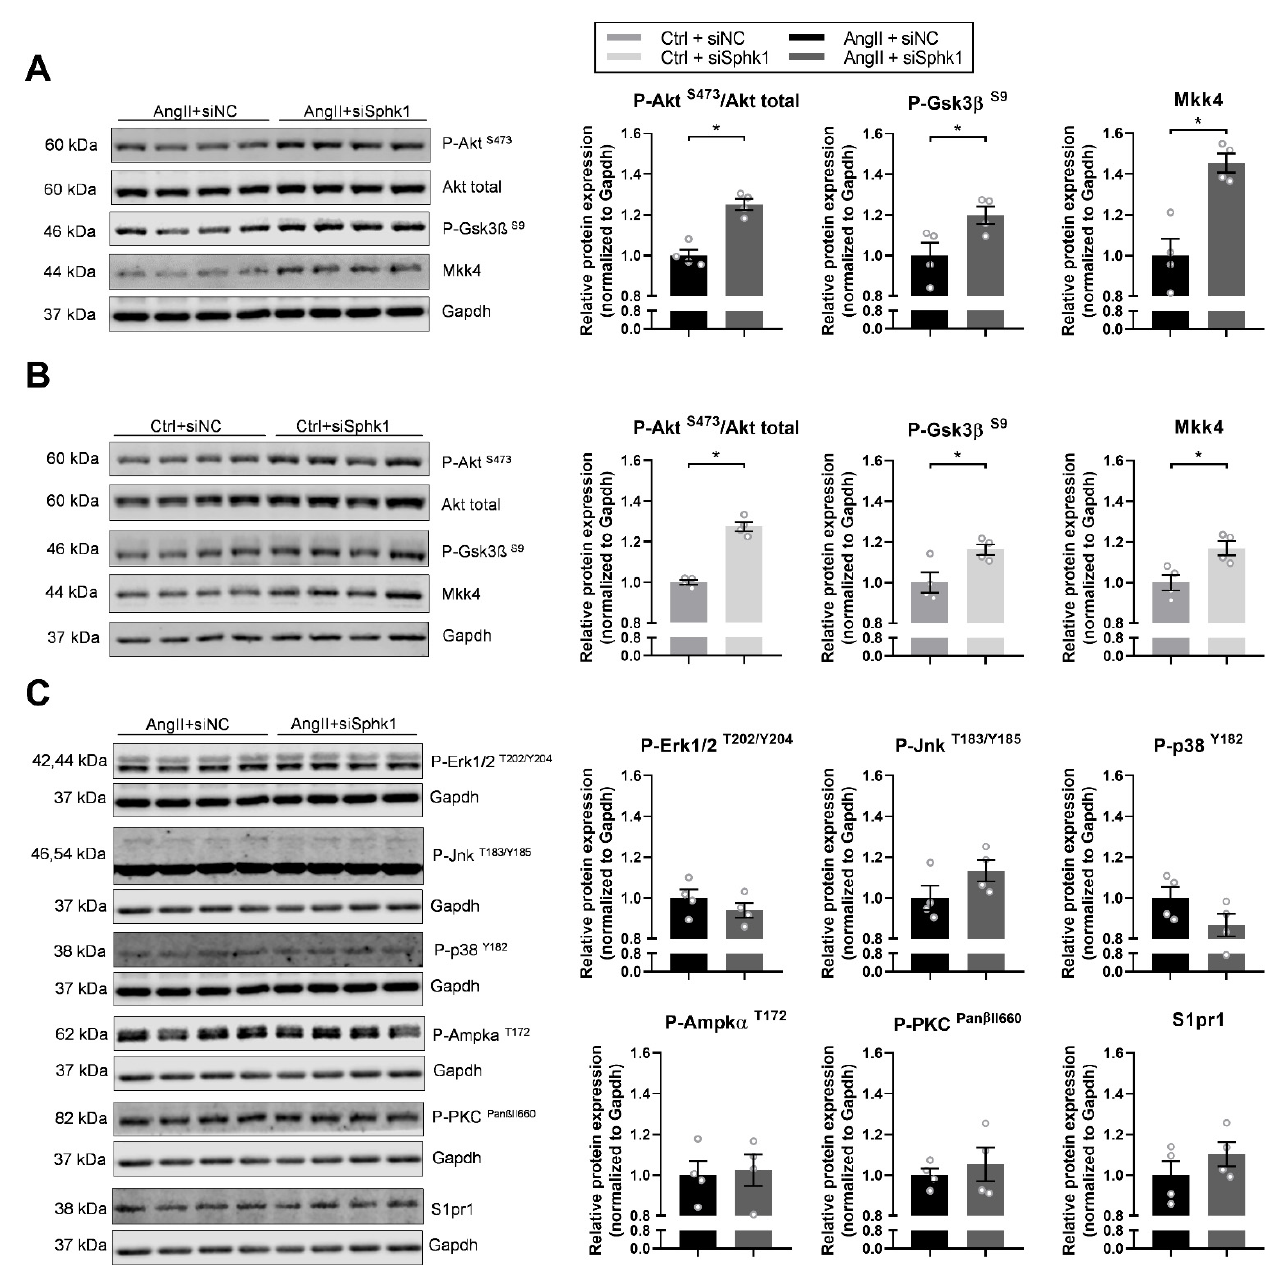
Figure 3. Key signaling pathways mediating the effects of Sphk1 silencing in neonatal CMs. ( A ) Western blot and densitometric analysis of the expression of P-Akt S473 , phosphorylated glycogen synthase kinase 3 beta (P-Gsk3 β S9 ) and mitogen-activated protein kinase (MAPK) kinase 4 (Mkk4) in siSphk1- or siNC-transfected and AngII- or ( B ) Ctrl-treated (24 h) neonatal CMs. Protein expression was normalized to GAPDH. ( C ) Western blot and densitometric analysis of the expression of phosphorylated extracellular signal-regulated kinases 1/2 (P-Erk1/2 T202/Y204 ), phosphorylated c-Jun N -terminal kinases (P-Jnk T183/Y185 ), phosphorylated p38 mitogen-activated protein kinase (P-p38 Y182 ), phosphorylated 5’AMP-activated protein kinase alpha (P-Ampk α T172 ), phosphorylated protein kinase C (P-PKC Pan β II660 ) and S1P receptor type 1 (S1pr1) in siSphk1- or siNC-transfected and AngII-treated (24 h) neonatal CMs. Protein expression was normalized to GAPDH. All data are represented as means ± SEM. * p < 0.05.